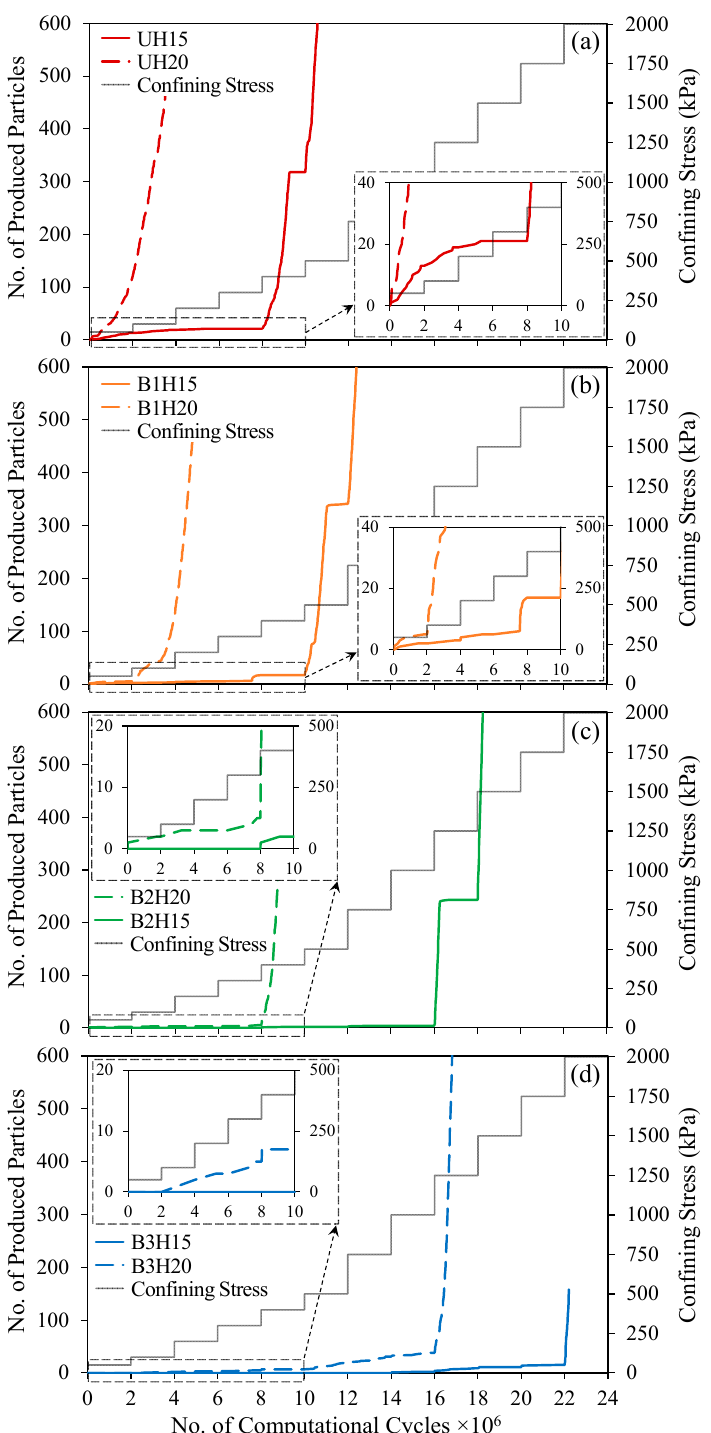
Figure 18. No. of produced sand vs number of computational cycles for models with: ( a ) Unbonded particles; ( b ) 50 N bonds; ( c ) 500 N bonds; and ( d ) 5000 N bonds. The impacts of the cavity size and model strength on the stress level causing catastrophic sanding (or simply, catastrophic stress) is shown in Figure 19. The horizontal axis in this figure denotes the normalized uniaxial compressive strength (UCS), the ratio of the UCS of each model to that of the weakest ones, i.e., B1 models (UCS = UCS/UCS min = UCS/UCS B1 ). The vertical axis in Figure 19 is the catastrophic stress ratio, defined as the ratio of the catastrophic stress for each model to the corresponding value of the weakest